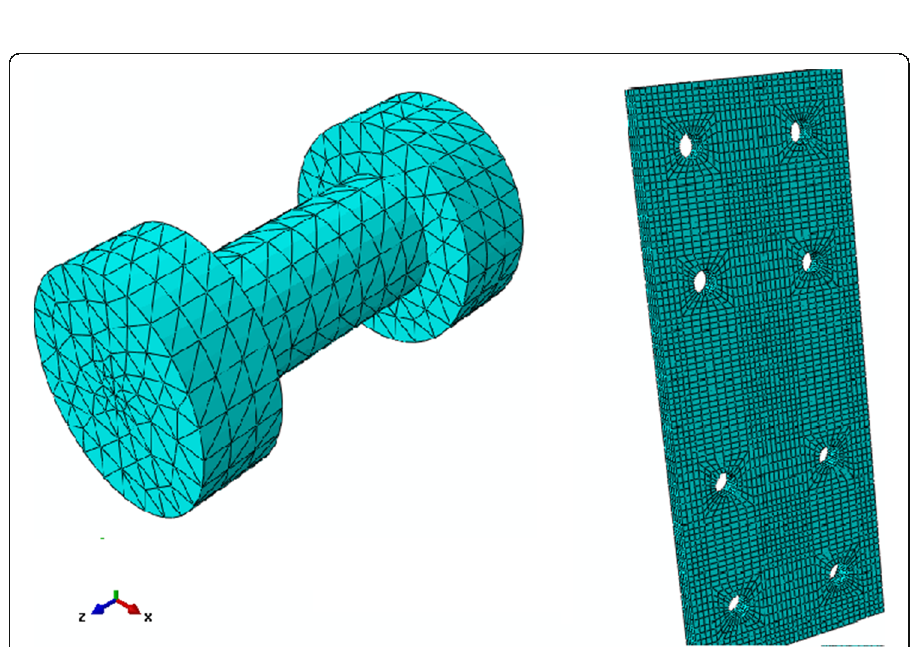
Fig. 3 Finite element model of end-plate and bolt simulation (mesh size 5